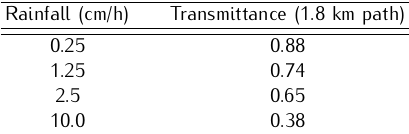
Table 5. Transmittance of a 1.8-km path through